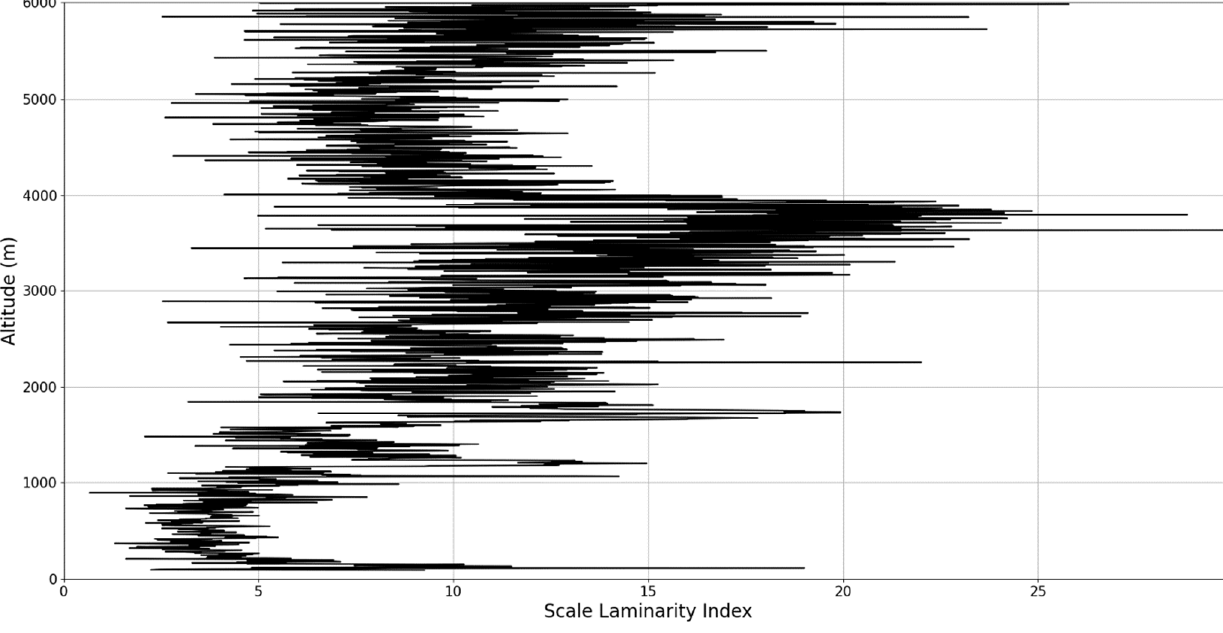
Figure 30. Zoomed-in scale laminarity index profile plot corresponding to point B.